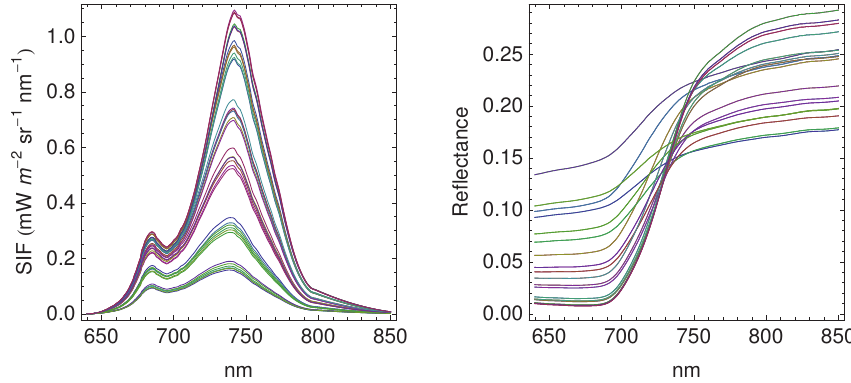
Figure A1. SIF and reflectance spectra simulated by SCOPE with parameters depicted in Table